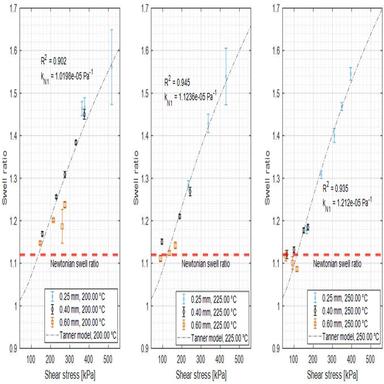
Swell ratio versus shear stress for various nozzle orifice diameters at a hot end temperature setpoint of 200 ◦C (left). Swell ratio versus shear stress for various nozzle orifice diameters at a hot end temperature setpoint of 225 ◦C (middle). Swell ratio versus shear stress for various nozzle orifice diameters at a hot end temperature setpoint of 250 ◦C (right). The dashed trendline on each plot represents the fitted Tanner model. The red, dashed, horizontal line at a swell ratio of 1.12 represents the sw